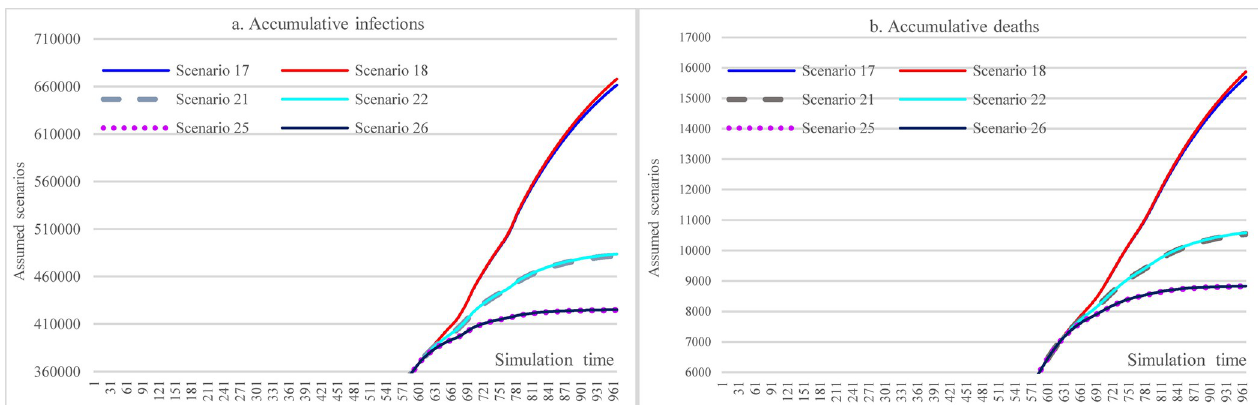
PLOS ONE | https://doi.org/10.1371/journal.pone.0271231 July 26,